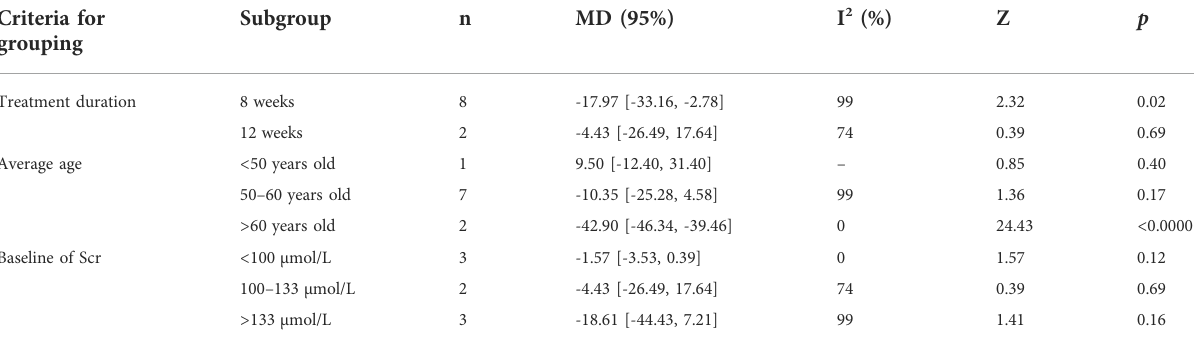
heterogeneity of patients in the group of average age more Furthermore, we looked for the sources of high than 60 years old and baseline of Scr less than 100 μ mol/L heterogeneity on Scr via subgroup analyses based on obviously decreased. Interestingly, the patients between the treatment duration, average age and baseline of Scr combination group and control group presented no and Supplementary Figures S4-S6). The